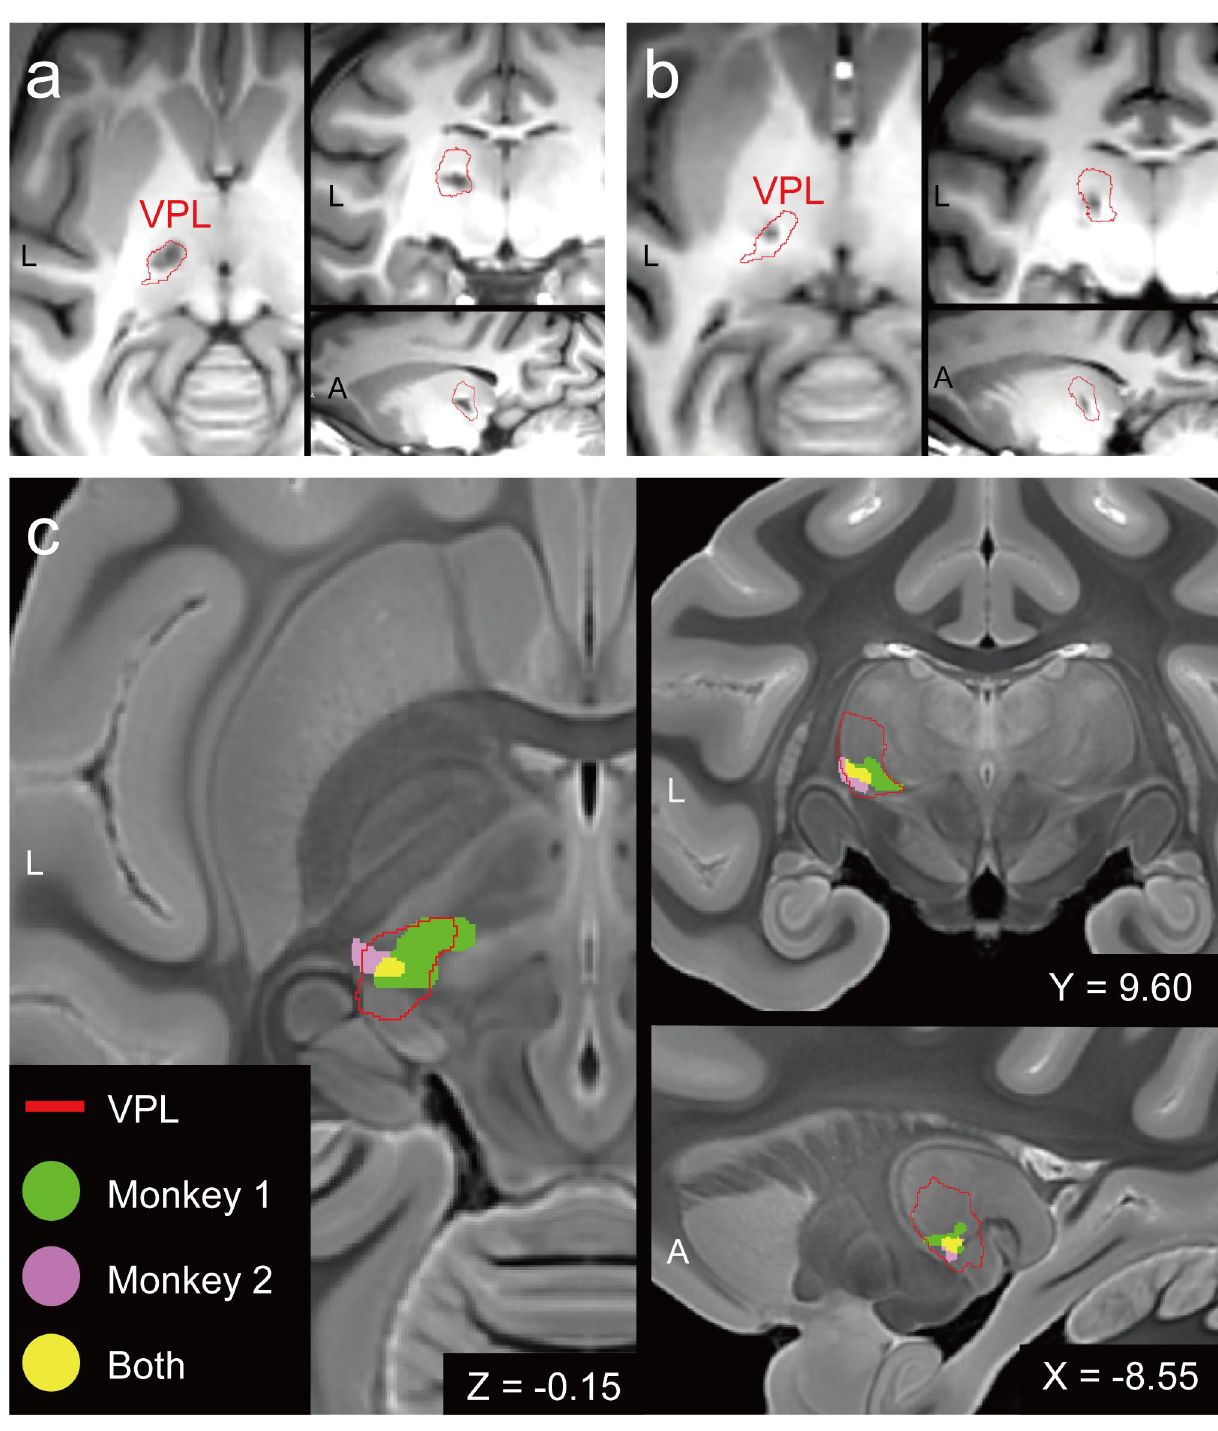
Figure 1. Location of the induced lesion on magnetic resonance images. Axial (left), coronal (upper right) and sagittal (lower right) slices are shown. ( a , b ) Individual T1-weighted magnetic resonance images taken 1 month after the collagenase injection for monkey 1 ( a ) and monkey 2 ( b ). The red lines indicate the edge of the VPL for lesion side warped from a monkey atlas. The lesions appear as low-intensity areas within the VPL. ( c ) The warped lesion for the two monkeys overlaid on the T2-weighted template image. Green, pink, and yellow areas indicate the lesion for monkey 1, the lesion for monkey 2, and the overlapped area, respectively. The xyz coordinate is defined at the anterior commissure. A anterior, L left, VPL ventral posterolateral nucleus in the